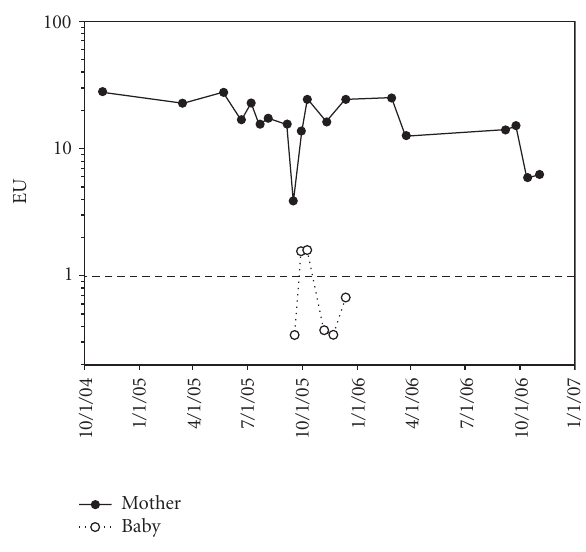
Figure 1: Blastomyces antigenuria during and after pregnancy for mother-baby